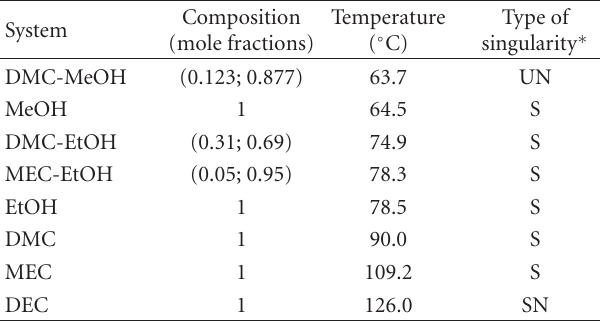
Table 6: VLE singularities in the system of MeOH, EtOH, DMC, MEC, and